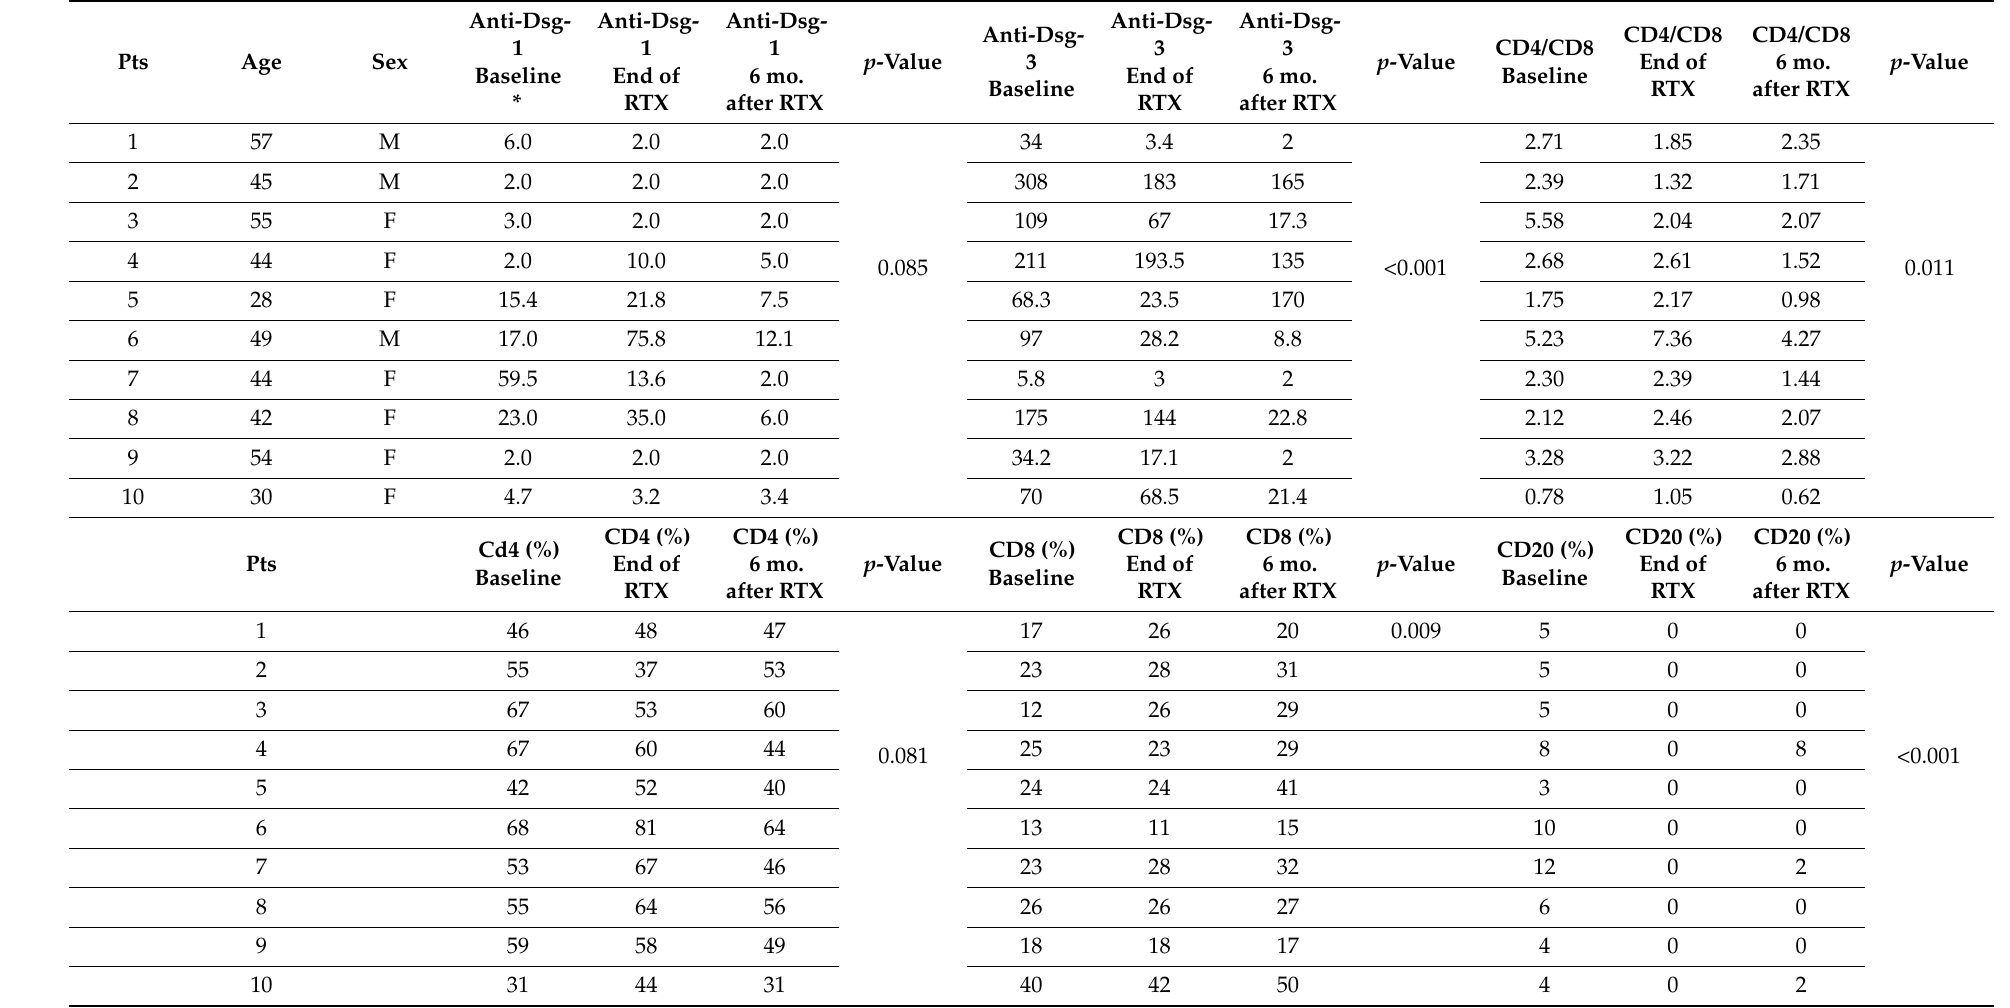
Table 2. Immunological characteristics of oral pemphigus vulgaris patients before and after therapy with